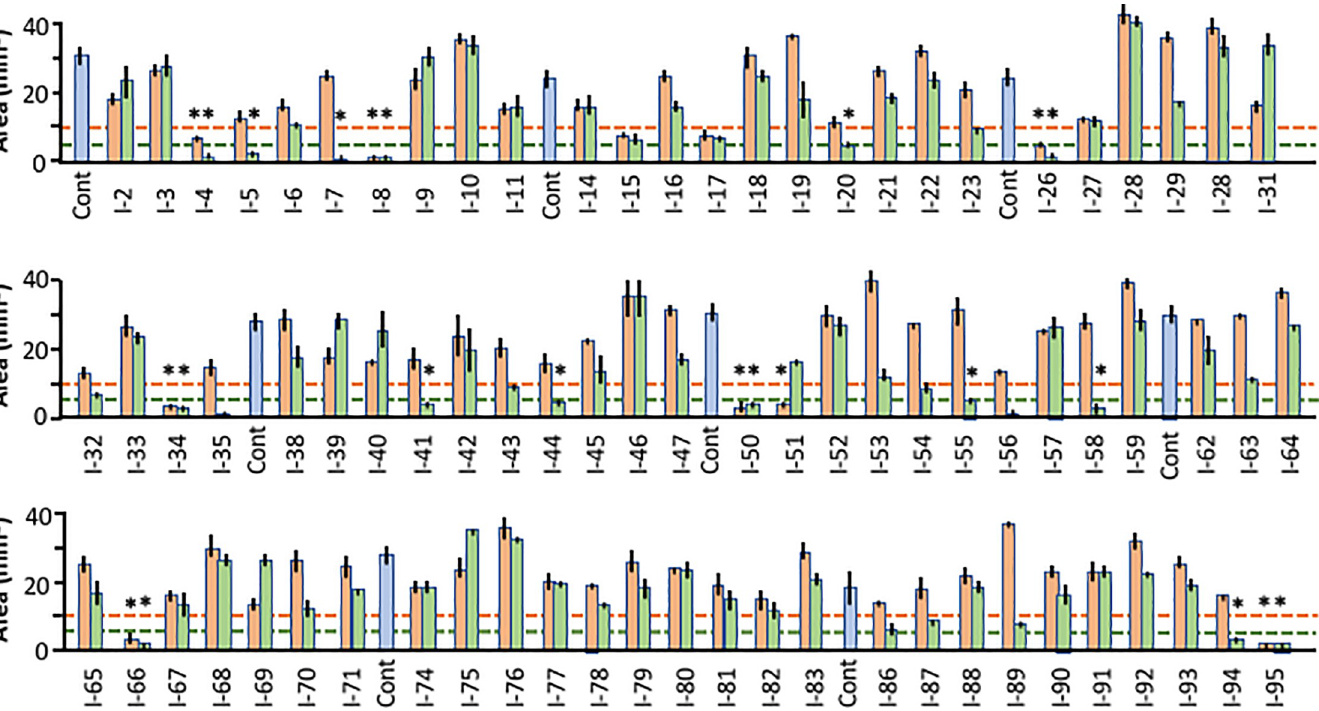
Fig 4. Effects of Library I inhibitors. Explant areas at 9 DIV for Library I, showing areas for control, explants (DMSO alone, blue bars) and inhibitors at concentrations of 0.5 (orange bars) and 5.0 μ M (green bars). The criterion threshold of growth suppression for each inhibitor concentration is shown as a dashed line. Inhibitors and concentrations that met the criterion thresholds are indicated by asterisks. All Library I inhibitors and their targets are listed in Table 1.